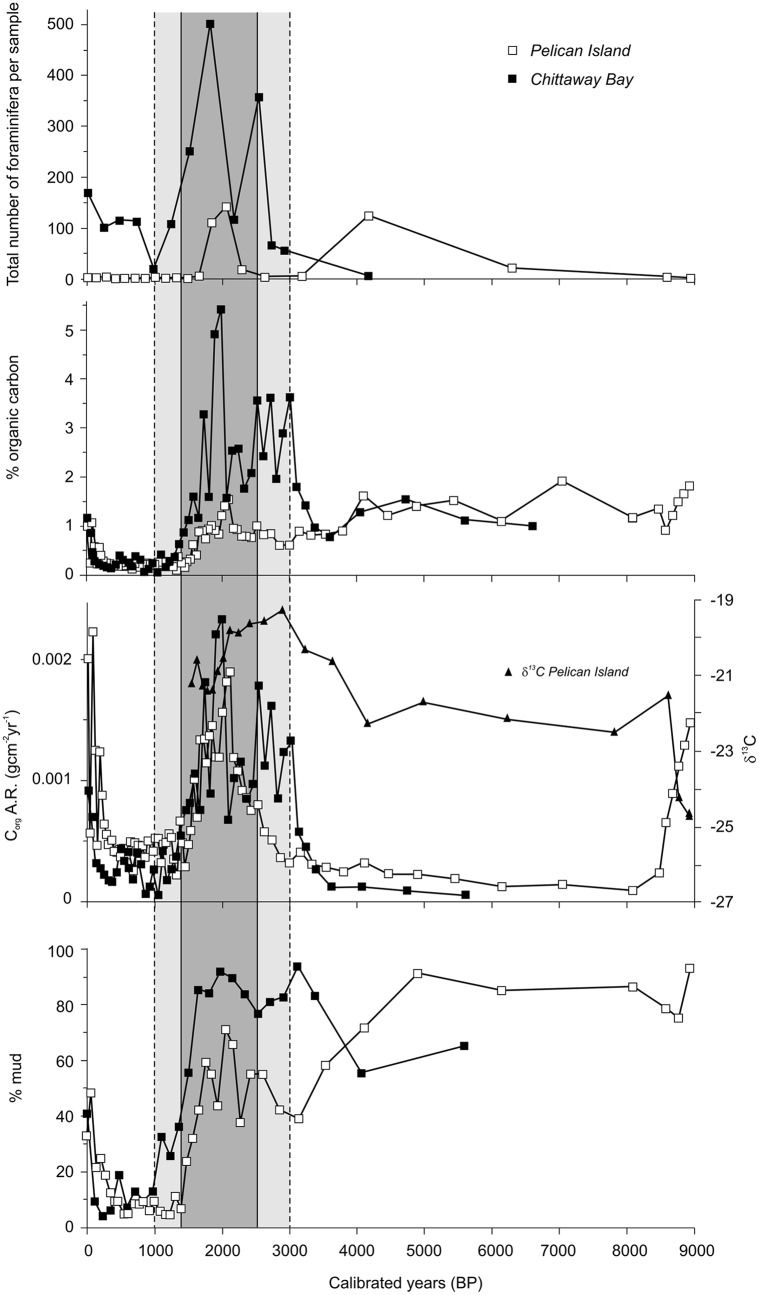
Sediment archives showing geochemical changes during the past 9000 years.Increased foraminifera abundance, % organic carbon (C), organic C accumulation rate (Corg A.R.), and % mud are observed during ENSO intensification (grey-shaded area) and since European settlement (~200 years ago). Darker shading indicates the peak period following re-establishment of ENSO after the mid-Holocene hiatus (Gagan et al. 2004). Sediment cores taken from Tuggerah Lake, NSW, Australia (Sites: PI—Pelican Island, CB—Chittaway Bay).